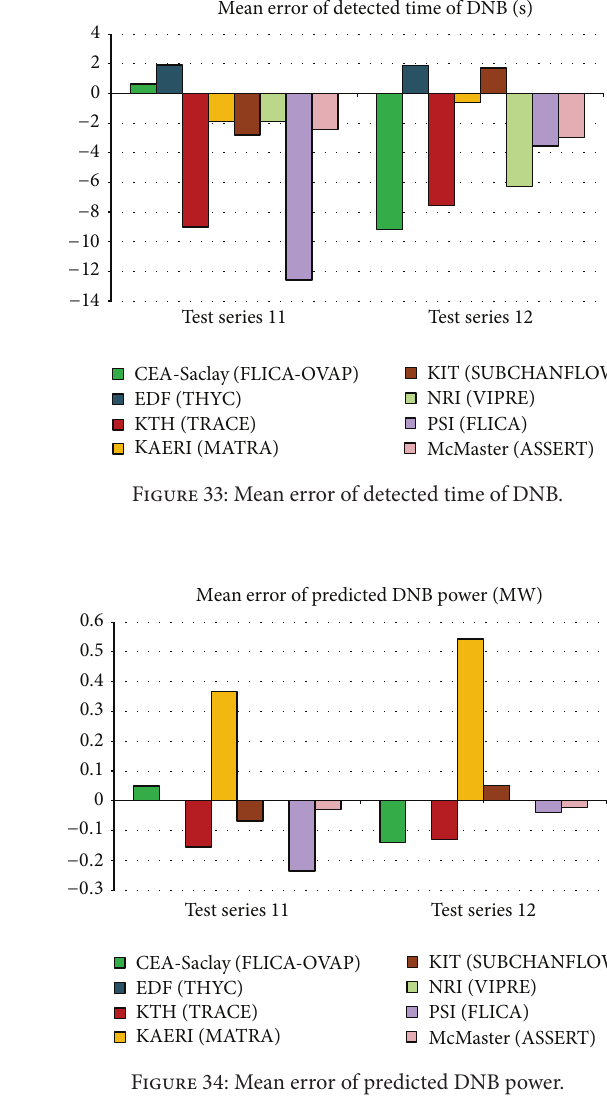
Figure 34: Mean error of predicted DNB